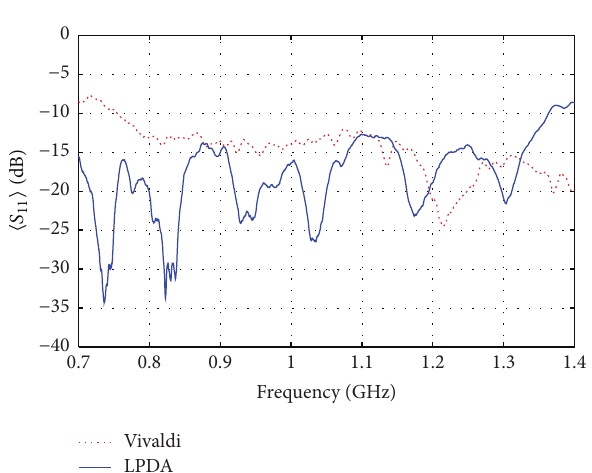
Figure 7: Measured reflection coefficients of